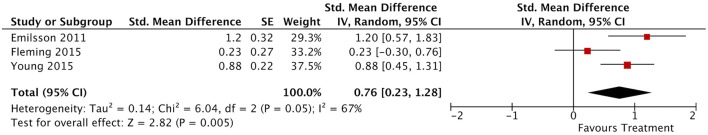
Forest plot for between-groups global functioning outcome.